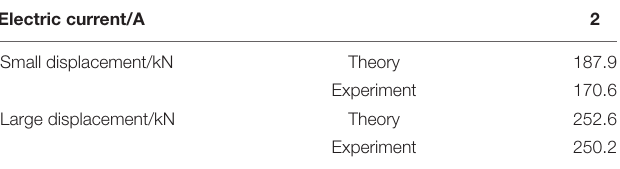
TABLE 3 | Comparison of theoretical value and experimental